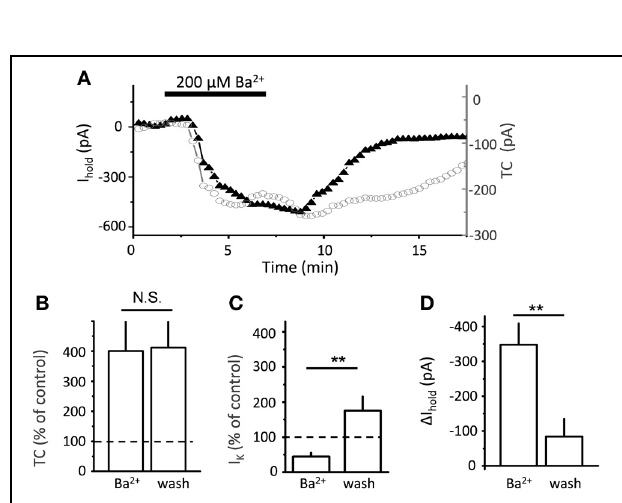
FIGURE 2 | Time-course of Ba 2 + effect on transporter current and K + current. (A) Bath-applied 200 µ M BaCl 2 produces downward shift in I hold (black triangles), and increase in transporter current (TC, empty circles) in a single cell. (B) Summary graph of mean normalized transporter current (TC, n = 5) in the presence of Ba 2 + and after 5min of washout (wash). (C) Summary graph of normalized K + current ( n = 5) in the presence of Ba 2 + and after 10min of washout (wash) (D) Summary graph of mean (cid:3) I hold ( n = 5) in the presence of Ba 2 + and after 10min of washout (wash). Error bars—SEM; ∗∗ P < 0 . 01; N.S.—non significant; One-Way ANOVA post-hoc Tukey